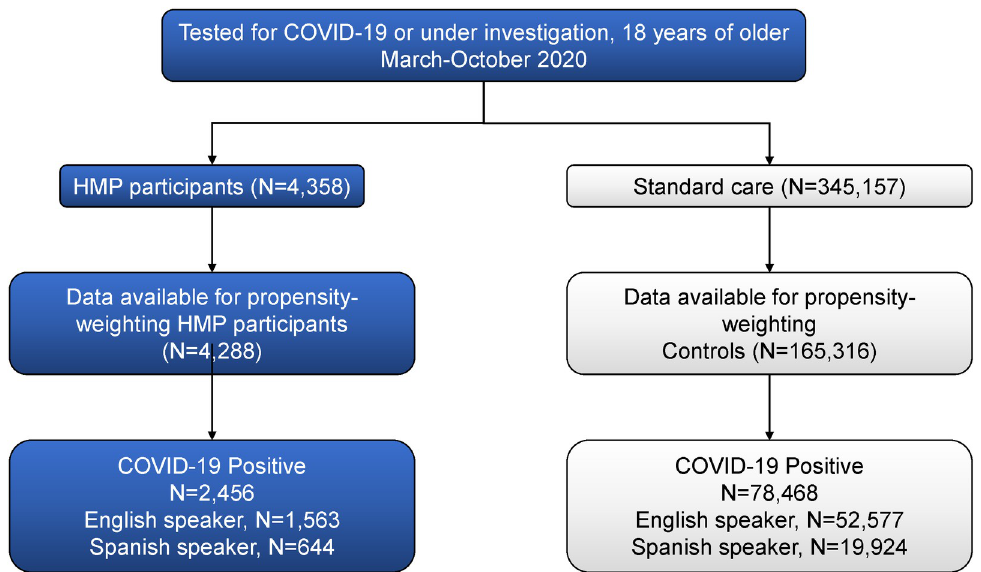
Fig 1. STROBE diagram. The flow diagram illustrates the retrospective selection of the COVID-19 home monitoring program (HMP) cohort and the control cohort. Propensity weighting was performed to minimize differences, so our sample was limited to individuals with the data elements needed for the weighting (see S1 Data for complete unweighted and weighted sample characteristics). Coefficients of the covariates were used to weight the regression model used to calculate risk of outpatient and primary care utilization and emergency department use. Final examination of COVID-19 positivity came from electronic health records as did patient primary preferred language. Of note, there were multiple primary languages in sample, which is why the breakdown of English and Spanish speaking patients do not sum to the total N for the HMP and standard care groups.